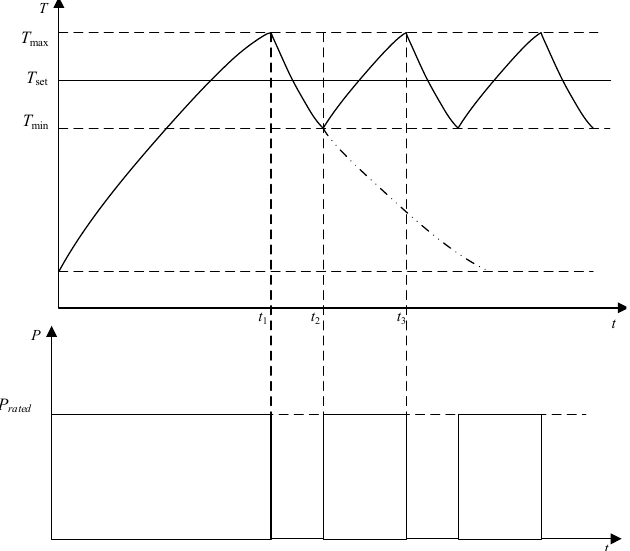
Figure 5. Variation curve of electric water heater temperature to power input.